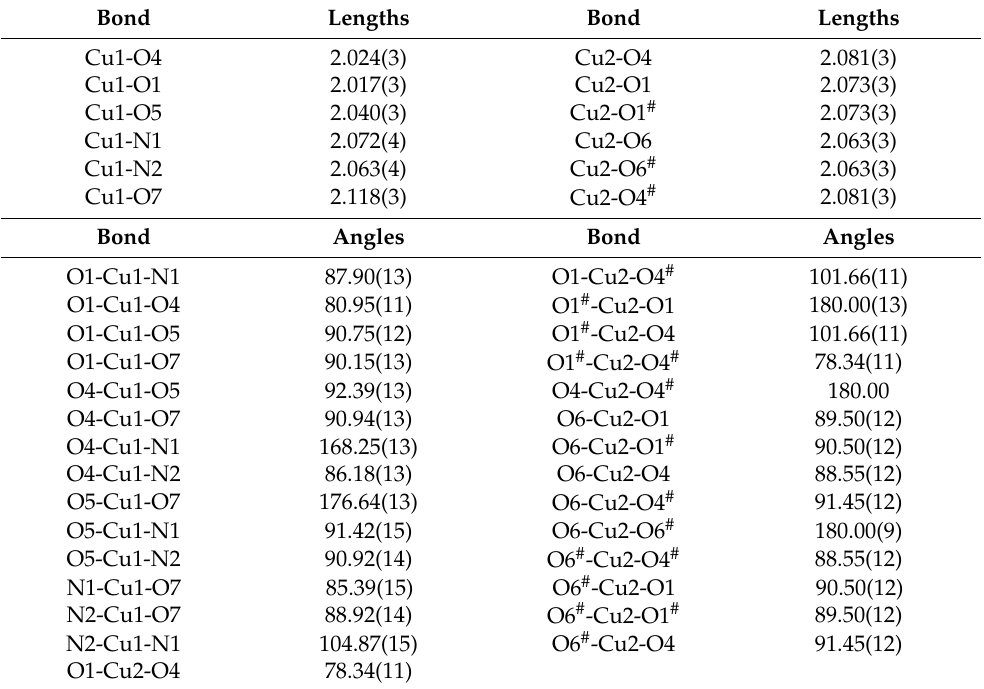
Figure 2. UV-Visible spectrum changes of H 2 L (10 μ M) upon addition of different amounts of Cu II ions (0~2 equiv.). Inset: The absorbance at 460 nm varied as an interaction of [Cu 2+ ]/[H 2 L]. Table 3. Significant bond lengths (Å) and angles ( ◦ ) of the Cu II